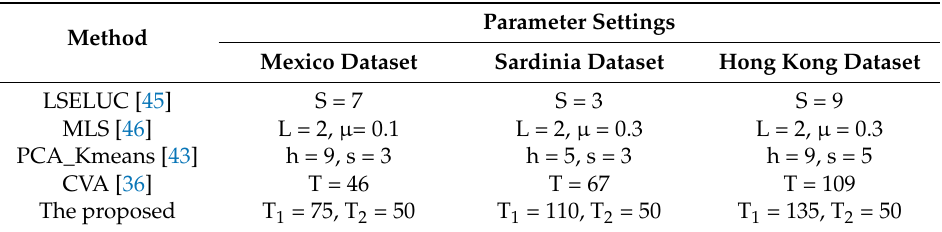
Table 1. Parameter settings of different LCCD methods for the three datasets.